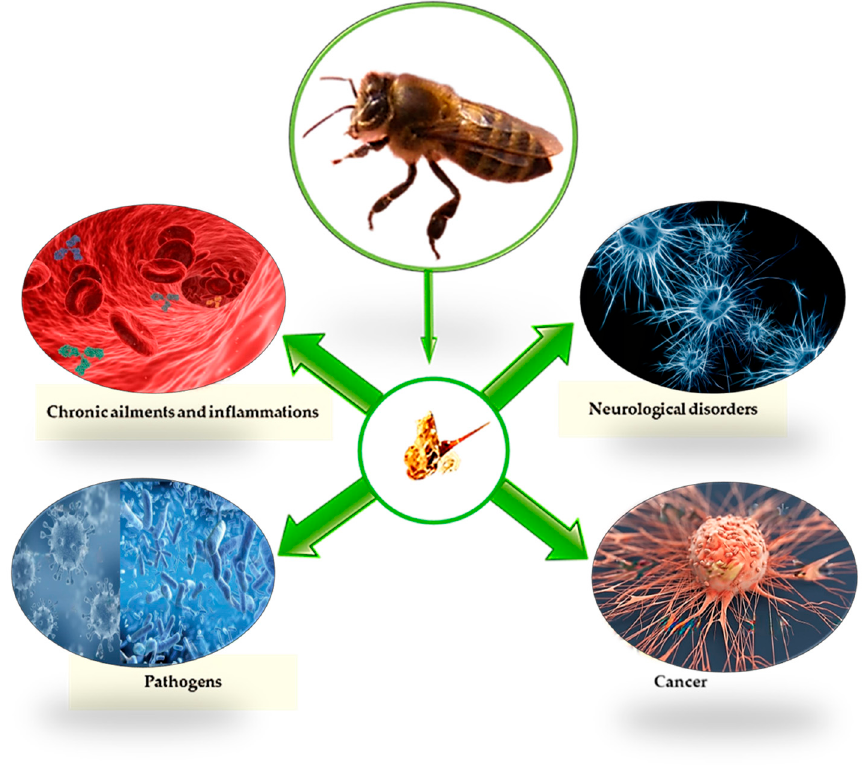
Figure 1. Schematic illustration of bee venom properties.